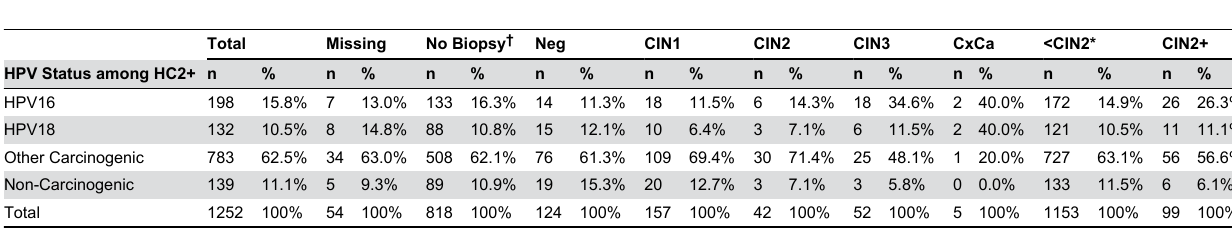
Table 4. The relationship of hierarchical HPV status and histologic